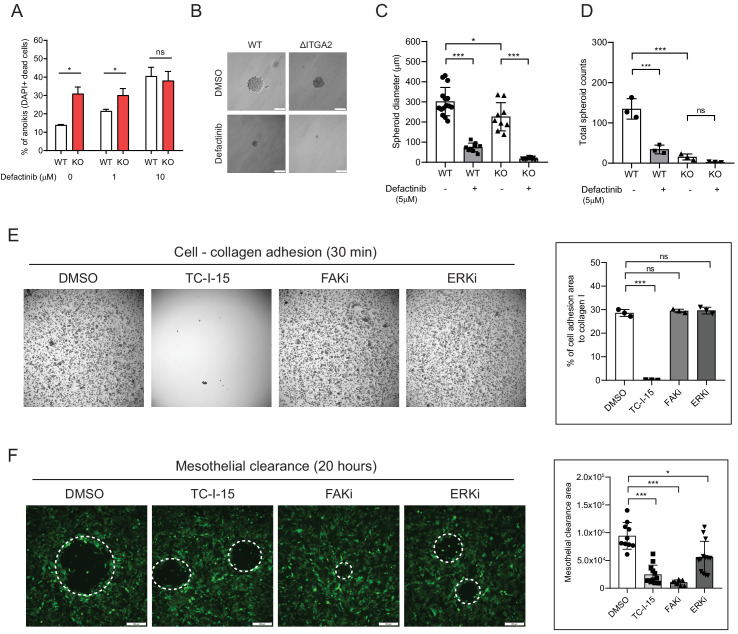
Functional inhibition of ITGA2-dependent FAK/MAPK signaling axis reduces spheroid formation, mesothelial clearance activity but not cell adhesion.(A) IGROV1 WT and ΔITGA2 cells were treated with 0, 1, or 10 μM of Defactinib for 16 hr and stained with Annexin V-FITC and DAPI to identify apoptotic dead cells. Data represent the mean ± SD (*p<0.05) from two independent experiments. (B) Anchorage-independent soft agar assay, cells were incubated with or without 5 μM of Defactinib for 10 days. Scale bar 100 μm. (C–D) Bar chart shows the quantification of total colony and the average diameters of spheroids (***p<0.001). (E) Cancer cell-collagen adhesion assay. Representative images show SKOV3 cell adhesion to collagen in the presence of DMSO, 1 μM of TC-I-15, Defactinib (FAK inhibitor) and FR180204 (ERK1/2 inhibitor). Bar chart with mean ± SD of the percentage of cell adhesion efficiency of cancer cells. (unpaired Student’s t-test, ***p<0.001). (F) Mesothelial clearance assay. SKOV3 cancer spheroids were seeded on top of a GFP-expressing MeT-5A mesothelial monolayer in the presence of DMSO or inhibitors for 20 hr. Mesothelial clearance area was measured by the size of black hole (white dash circle) using Image J software. Bar chart represents mean ± SD of clearance area from two independent experiment. Scale bar 200 μm.